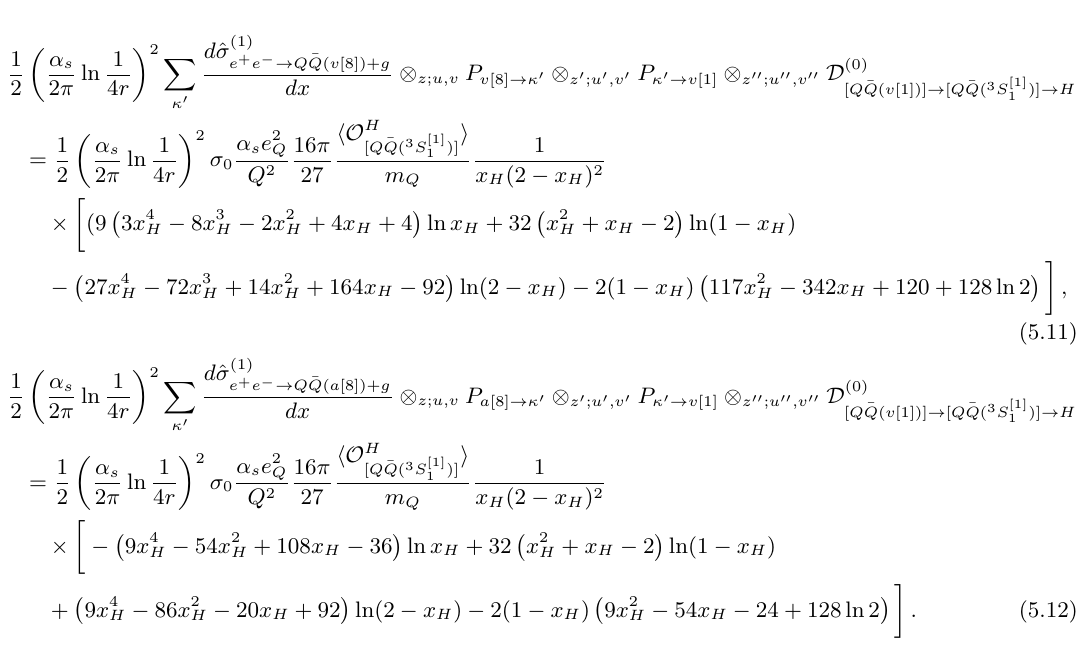
Figure 9 . The e(cid:11)ect of including the leading logarithm from evolution equation (5.4) on the ratios of the full pQCD and NRQCD results, (^ k (1) + ^ k (2) ) = ^ f for the 3 S [1] 10, 30, and 100 GeV. We include the perturbative uncertainty bands by varying the factorization scale from E H = 2 to 2 E H (yellow band). The central scale choice, (cid:22) = E H , is indicated by the black-dashed